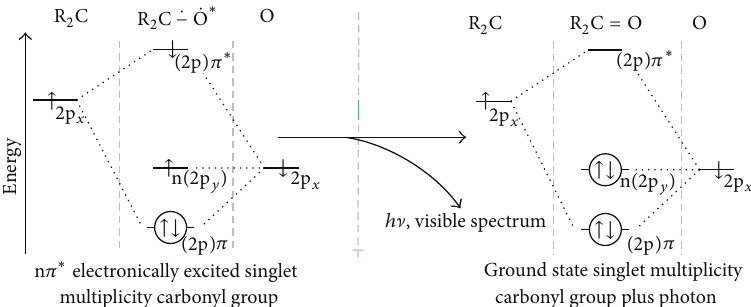
Figure 6: Relaxation (pi antibonding to nonbonding ( 𝜋 ∗ → n) electronic orbital transition) of a singlet electronically excited carbonyl product of dioxygenation to its singlet ground state by photon